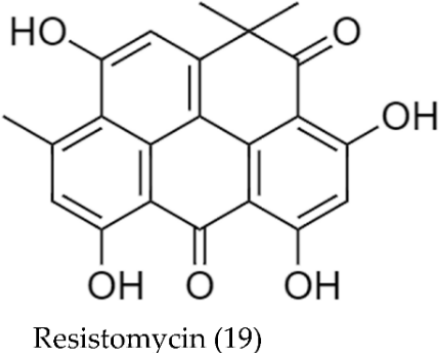
Figure 14. Chemical structures of resistomycin. Otherwise, melanins (Figure 15) are polymers with diverse structures and brown to black colorations [116]. They have multiple important functions and are formed by the oxidative polymerization of phenol and/or indolic compounds; however, their structures are not well understood [55]. Actinobacteria members produce a dark pigment, melanin, which is considered valuable for taxonomic relatedness [116].